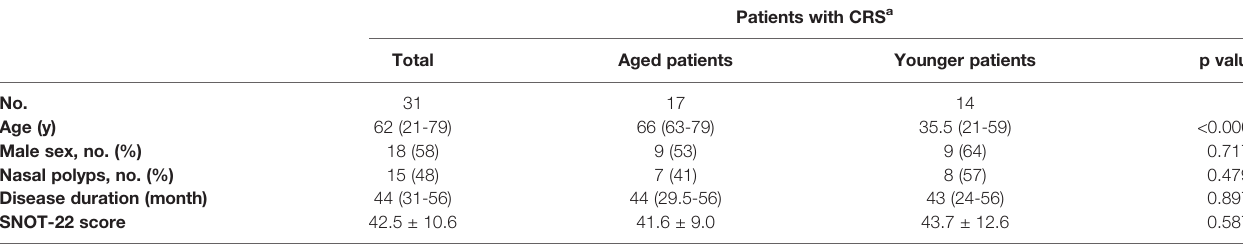
TABLE 1 | Differences in demographic and clinical characteristics between aged and younger patients with CRS.